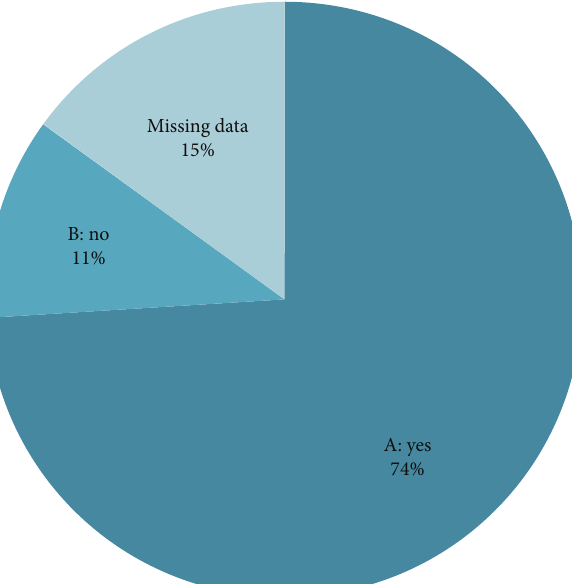
Figure 3: RSV statement in guidelines. Heat map according to the responses in the questionnaire about the presence of a guideline and the presence of a statement in the